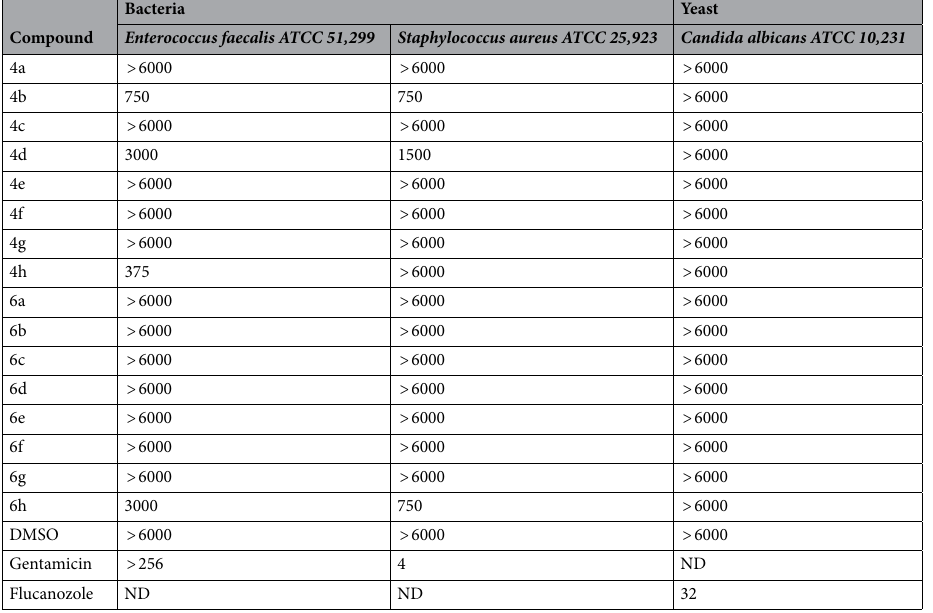
Table 4. Minimal inhibitory concentration (MIC) values of complexes against wild-type microorganisms (μg/ ml).